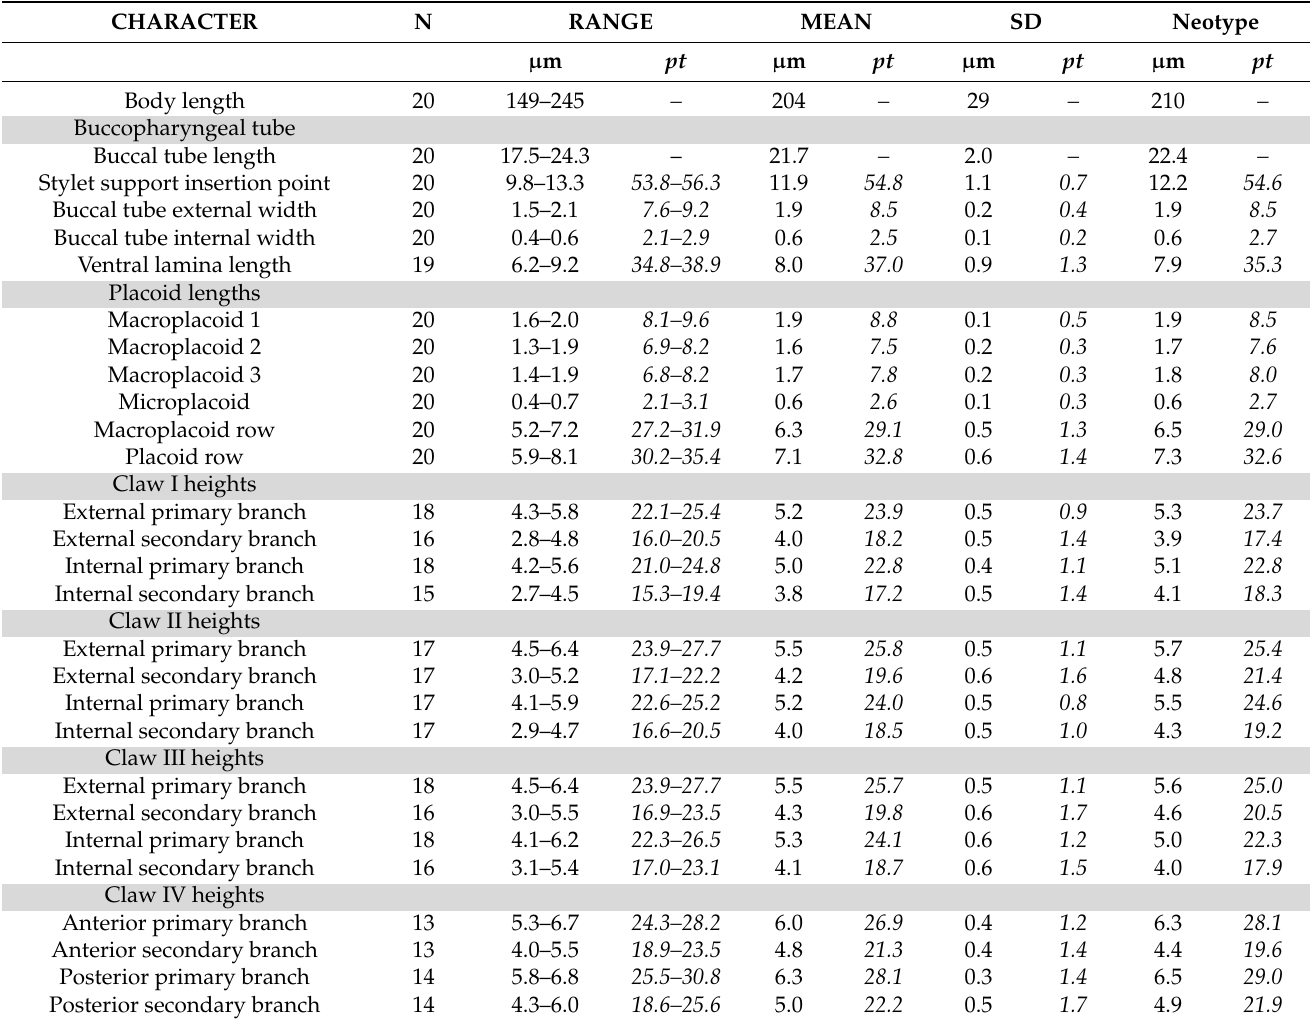
Table 1. Measurements [in µ m] of selected morphological structures of individuals of Minibiotus intermedius mounted in Hoyer’s medium (N—number of specimens/structures mea- sured, RANGE refers to the smallest and the largest structure among all measured specimens; SD—standard deviation).